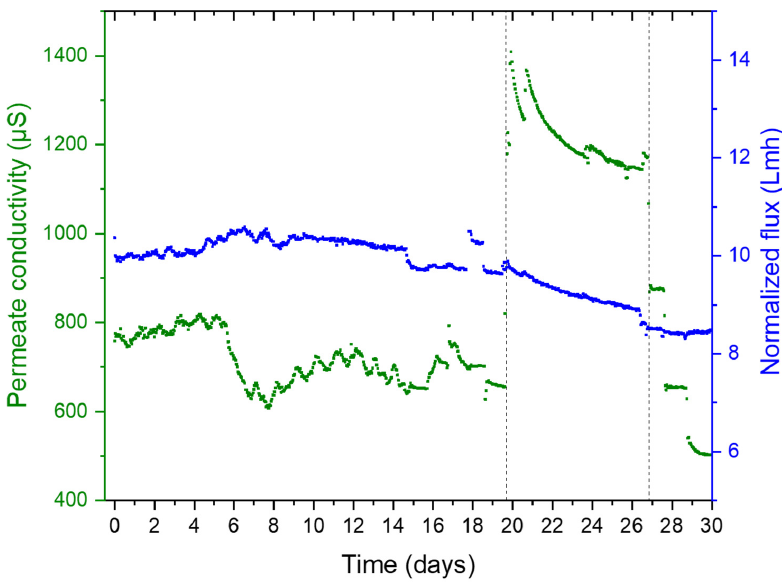
Figure 4. Variations in the permeate conductivity and flux during the pilot operation.